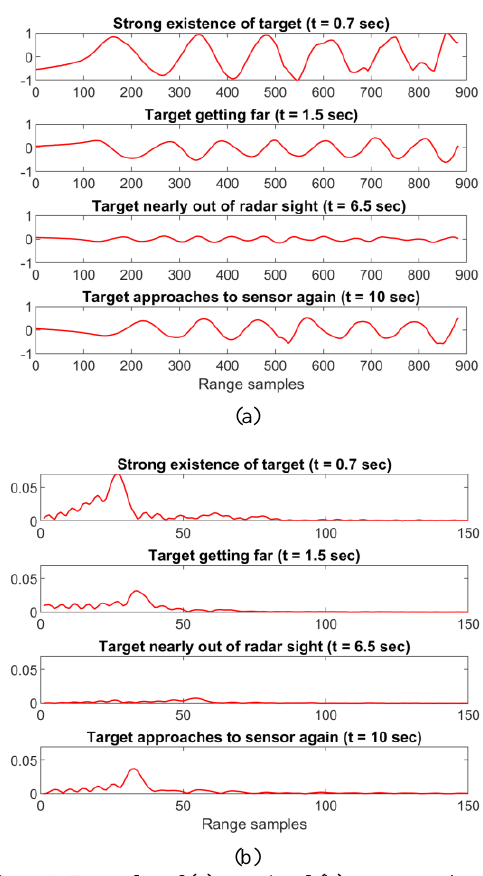
Figure 5. Examples of (a) raw signal (b) compressed range signal in radar ranging experiment